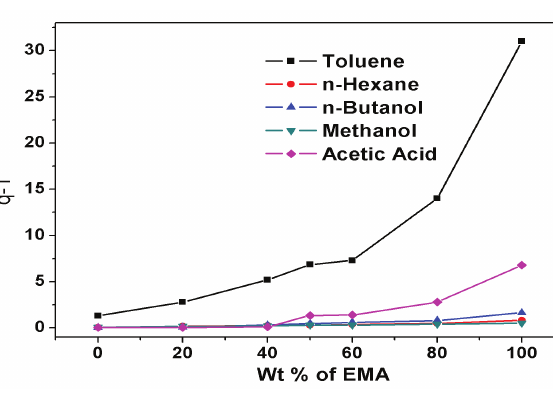
Figure 7: Swelling index (q – 1) versus weight percent of EMA in NBR/EMA blends.